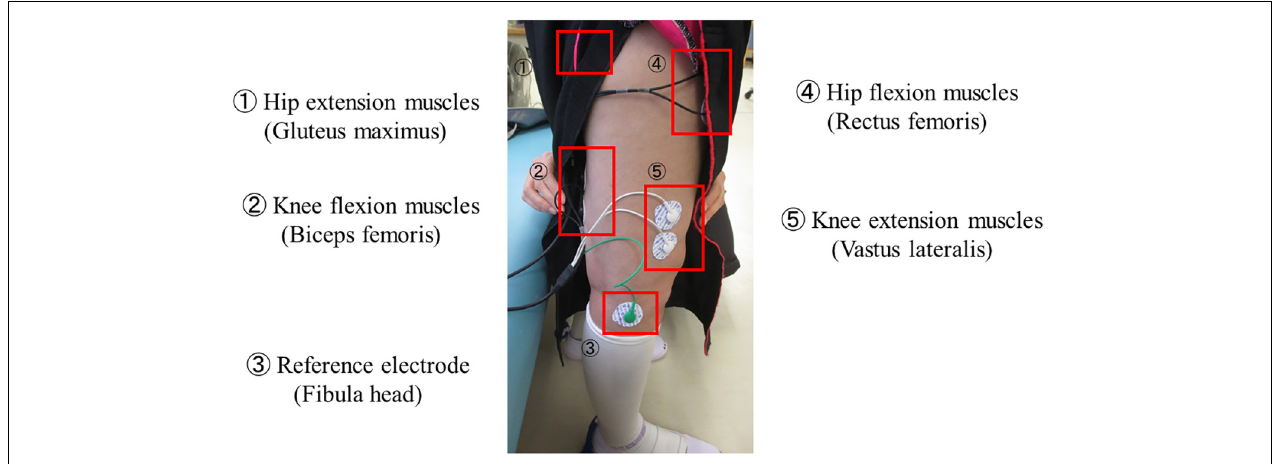
FIGURE 2 | Example of BES sensor. Electrodes are attached to the surface of the wearer’s skin over the hip and knee flexion and extension muscles to detect the nerve and muscle action potentials as BES. BES, bioelectrical